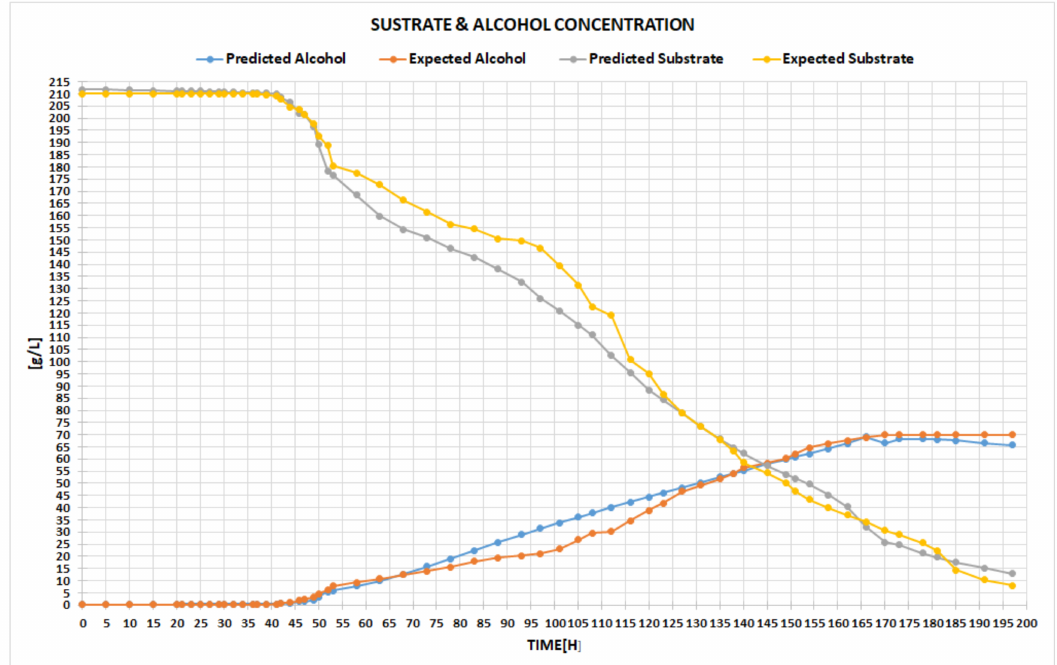
Figure 9. Expected and predicted outputs vs.